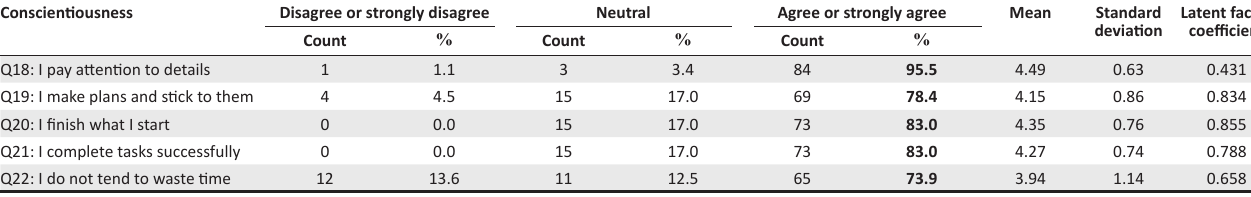
TABLE 4: Descriptive statistics for the construct of conscientiousness. Conscientiousness